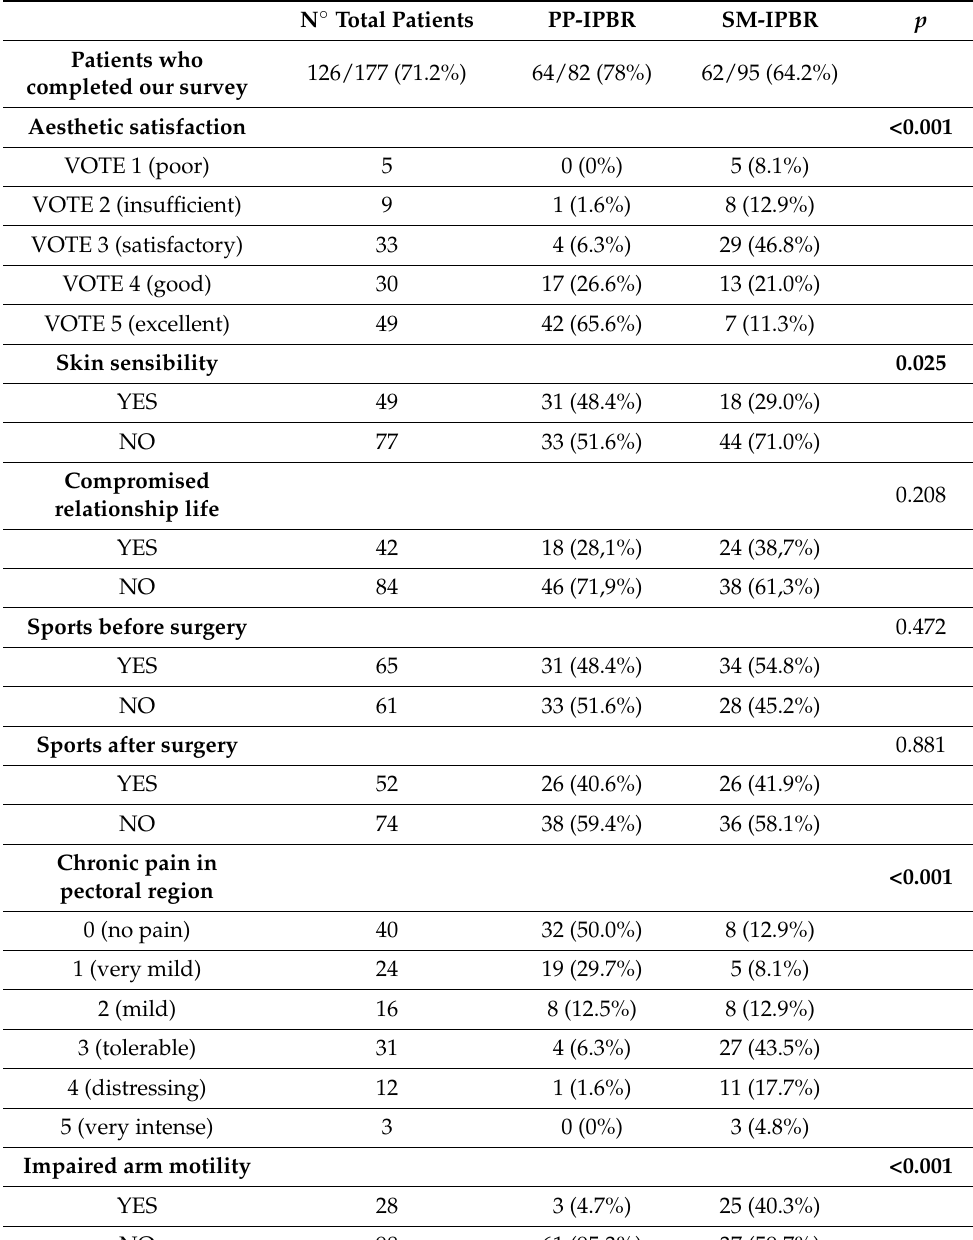
Table 5. QOL assessment PRO survey